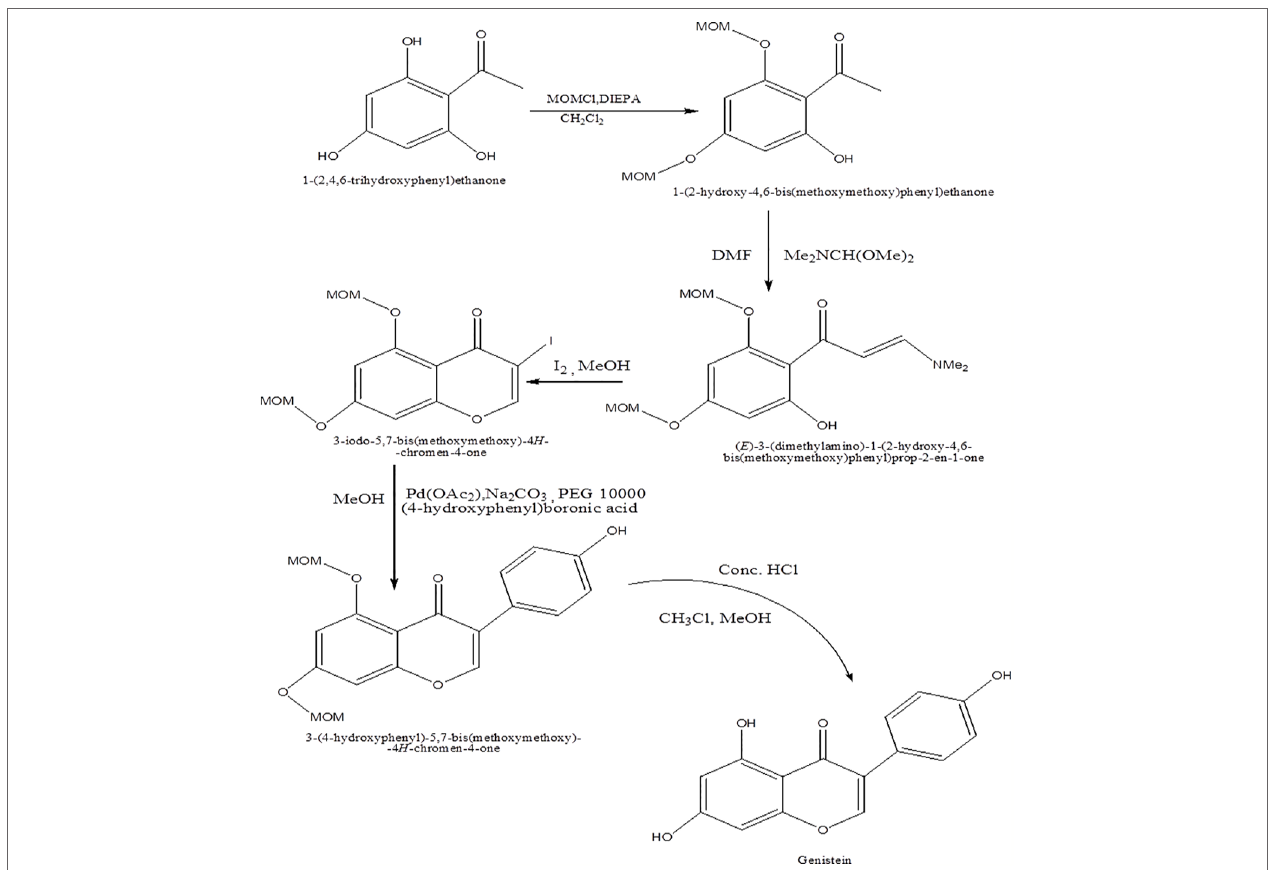
FIGURe 3 | Synthesis of genistein from 1-(2,4,6-trihydroxyphenyl)ethanone.